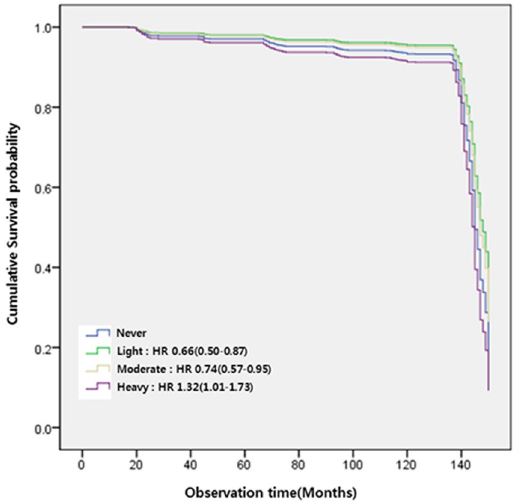
Figure 1. Kaplan-Meier curve of the incidence of type 2 diabetes by alcohol consumption pattern.